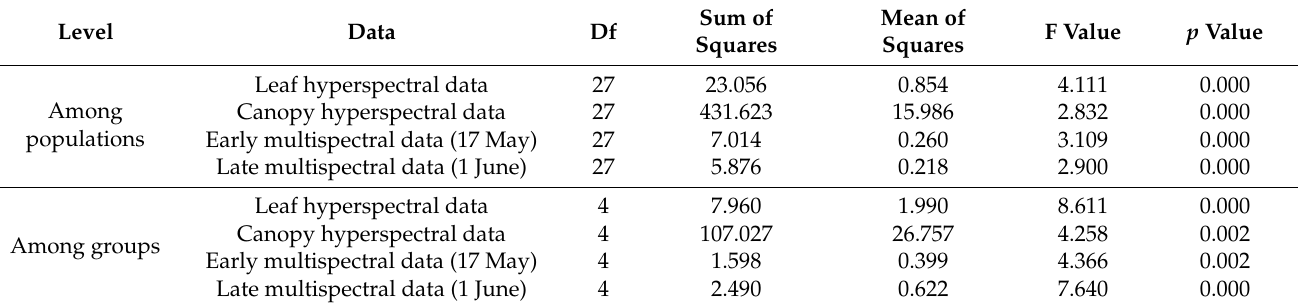
Table 3. Analysis of variance (ANOVA) for the 28 population groups and the 5 genotypic groups of Bermuda grass based on hyperspectral, early (17 May) and late (1 June) multispectral datasets, with the first PC of the PCA as a response variable. The F value is the ratio of between-group variation and within-group variation for both the population groups and the genotypic groups.